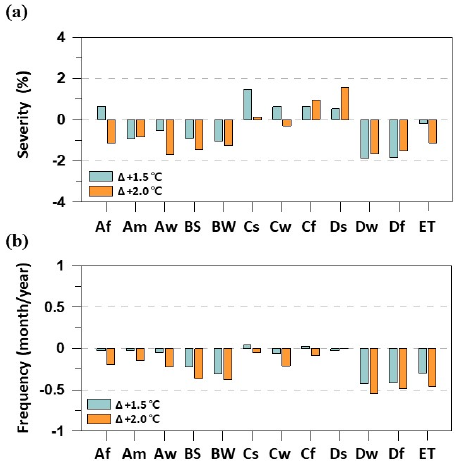
Figure 9. Changes in annual mean ( a ) value of severe drought (unit: %); ( b ) frequency of severe drought (unit: times/year) based on SPI under 1.5 and 2.0 °C global warming compared to the reference period in the Asian monsoon region.